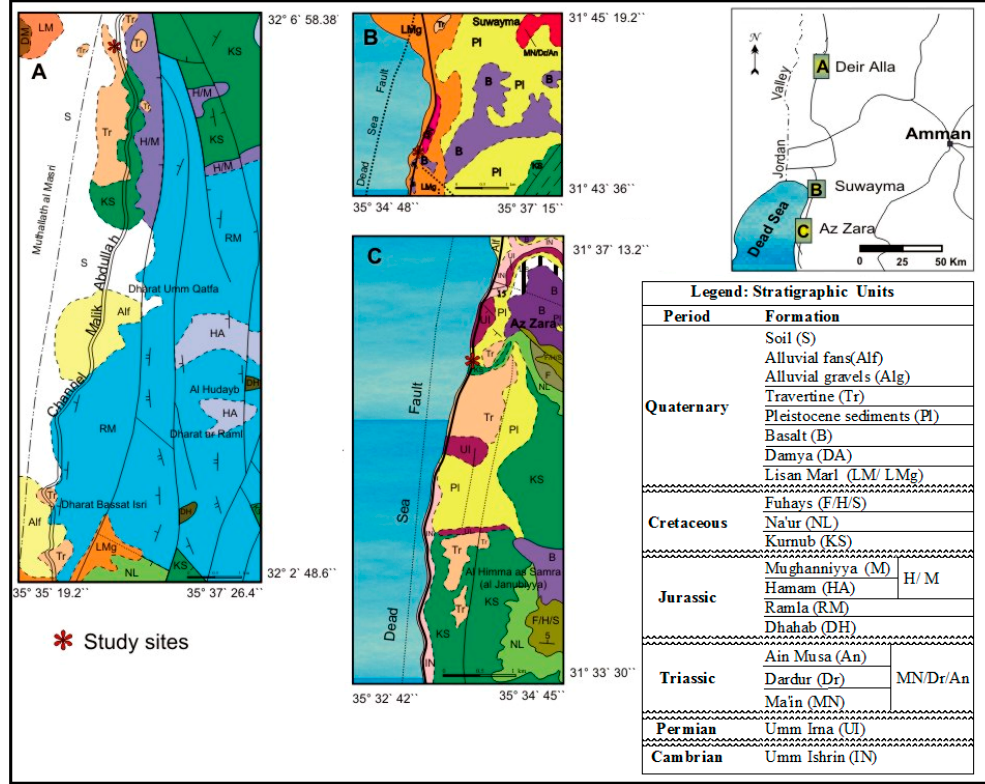
Figure 2. Geological maps of the studied travertine outcrops.